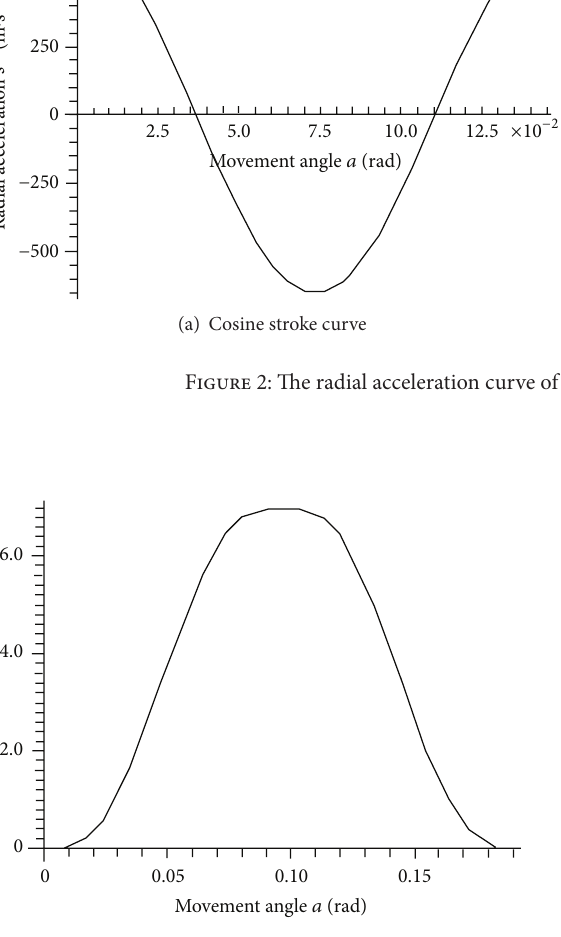
Figure 3: The whole cycloid stroke curve.